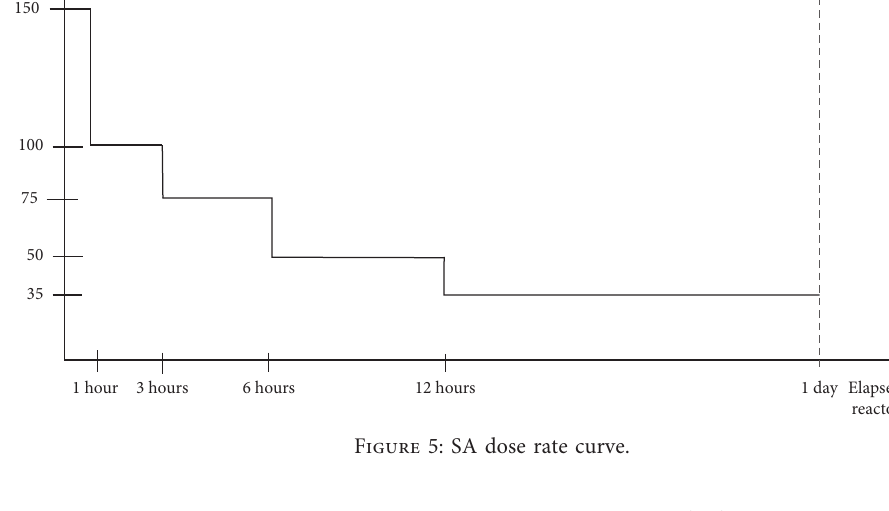
Figure 5: SA dose rate curve.